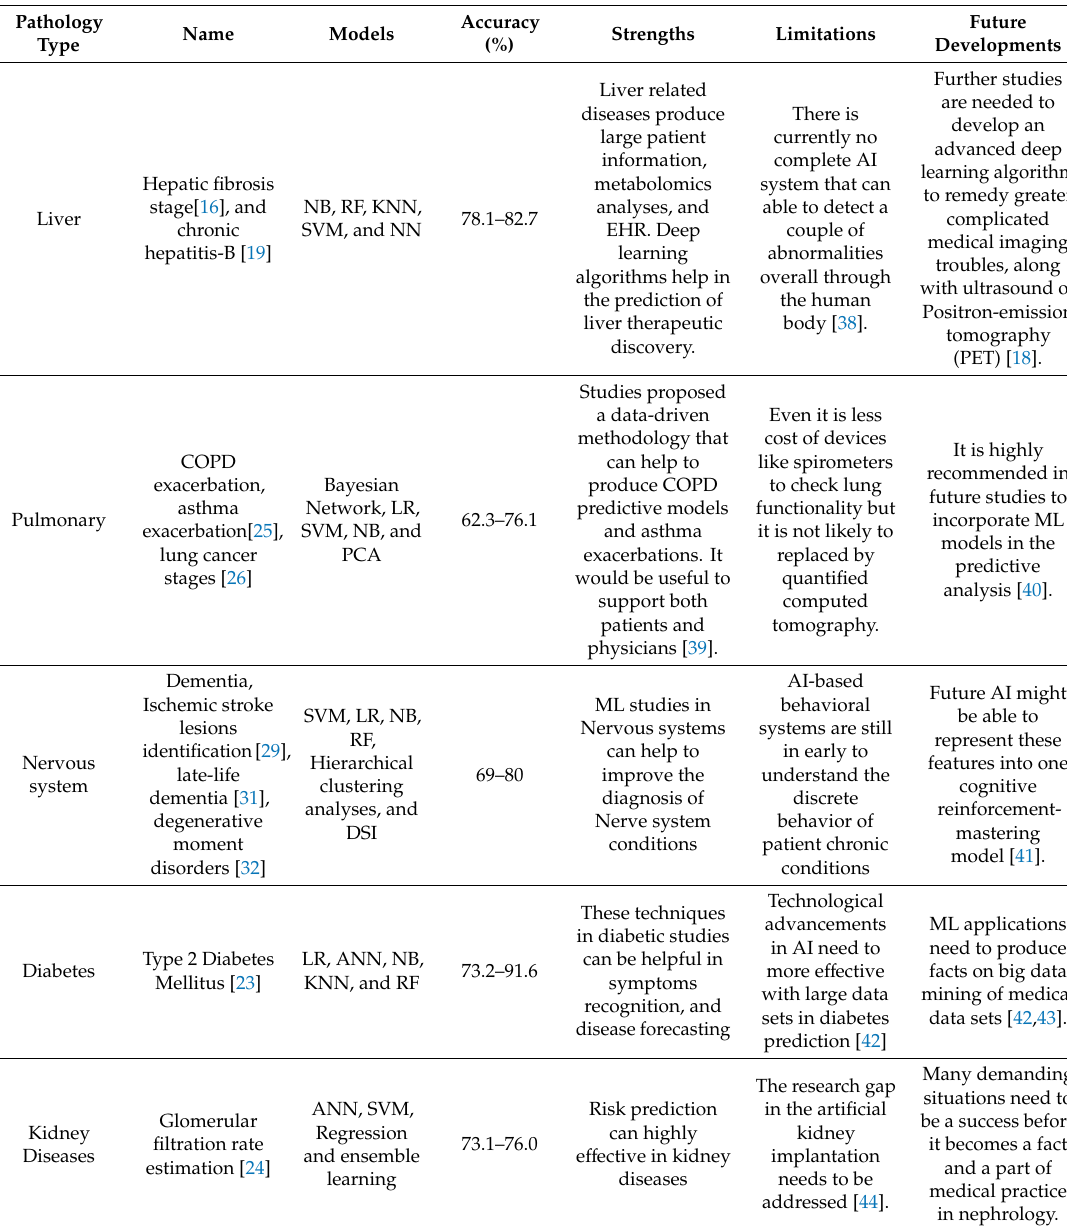
Table 2. Pathology types with used models and their strengths and